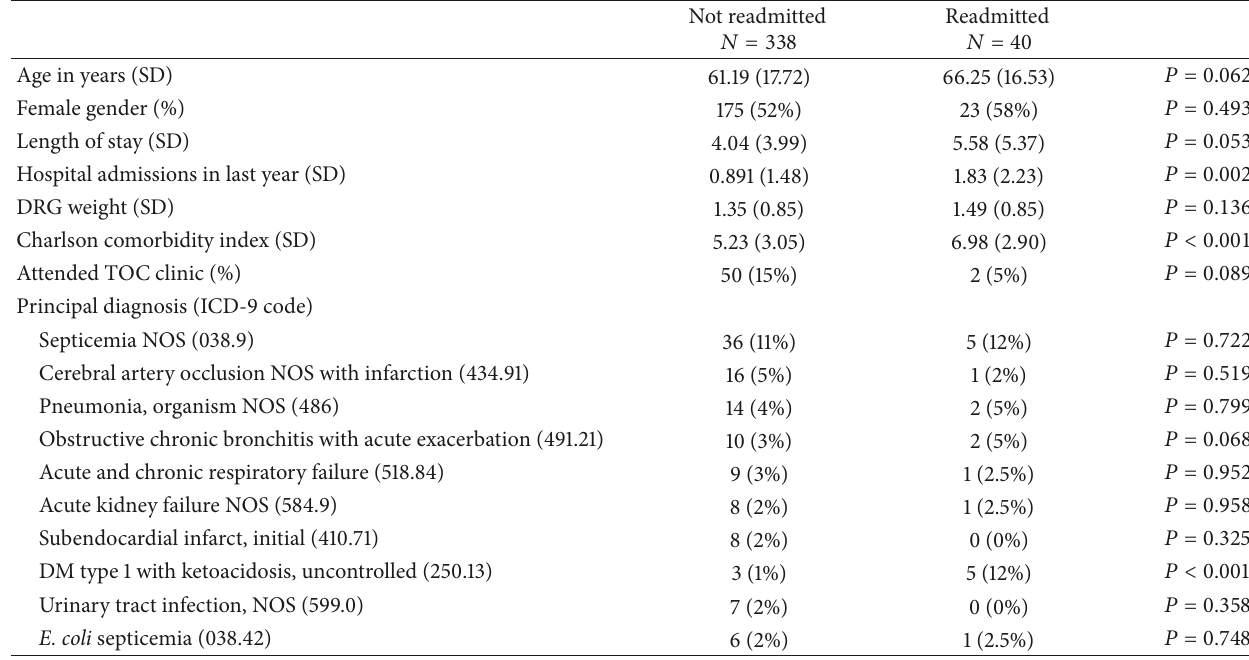
Table 1: Patient characteristics.